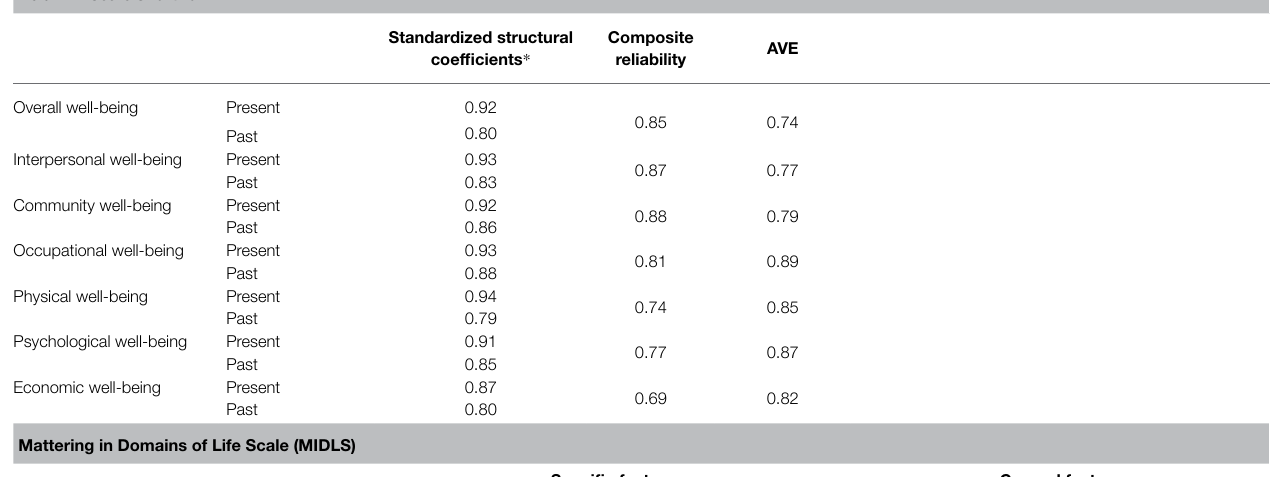
TABLE 2 | Validity and reliability measures of the Measurement model. I COPPE scale short